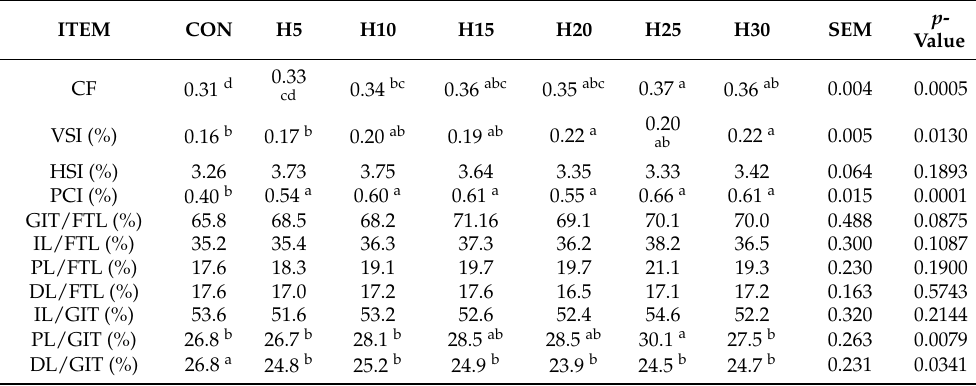
Table 3. Somatic indices in Siberian sturgeons fed experimental diets containing increasing shares of black soldier fly full-fat larvae meal.